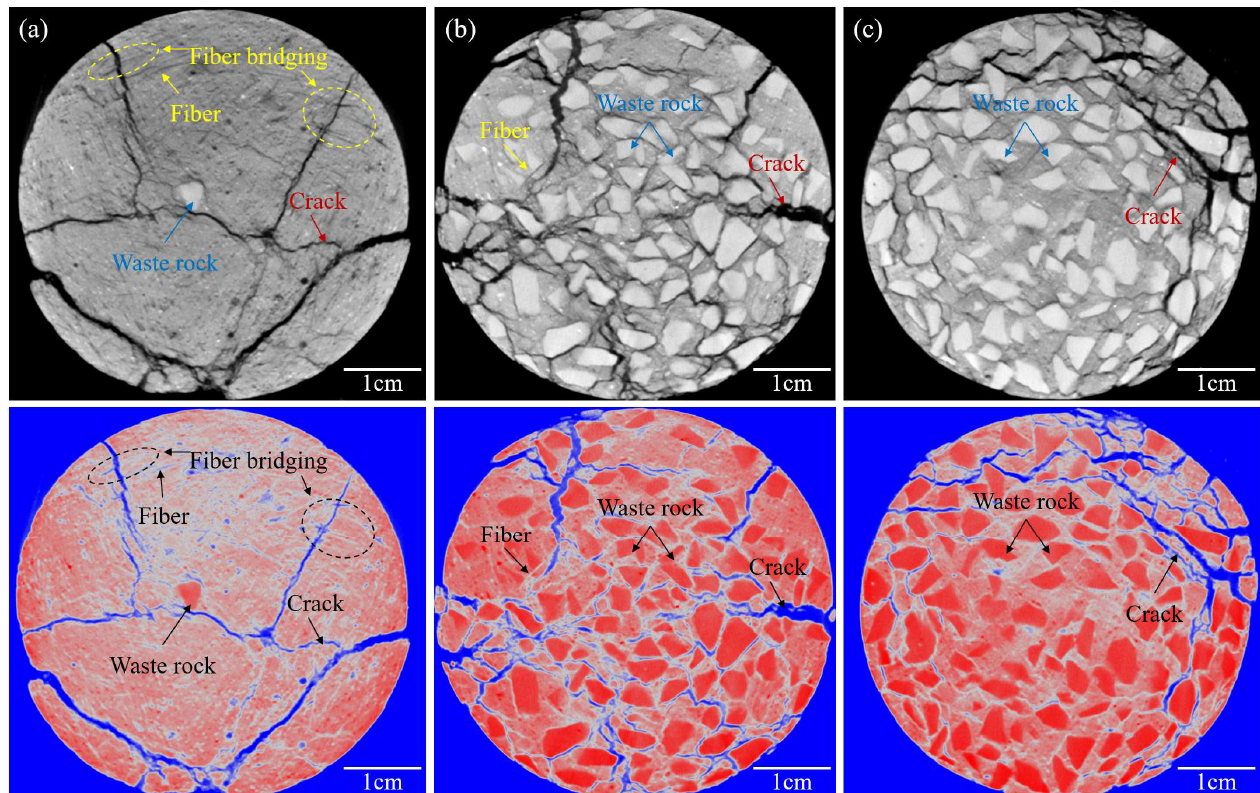
Figure 5. 2D CT images of PP6-0.6: ( a ) Z = 80 mm; ( b ) Z = 50 mm; ( c ) Z = 20 mm.